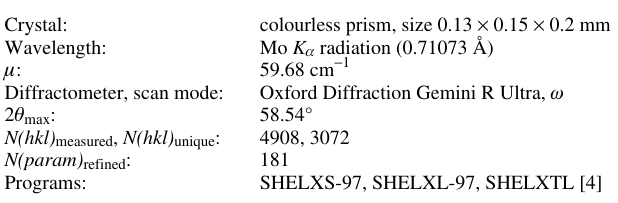
Table 1. Data collection and handling.